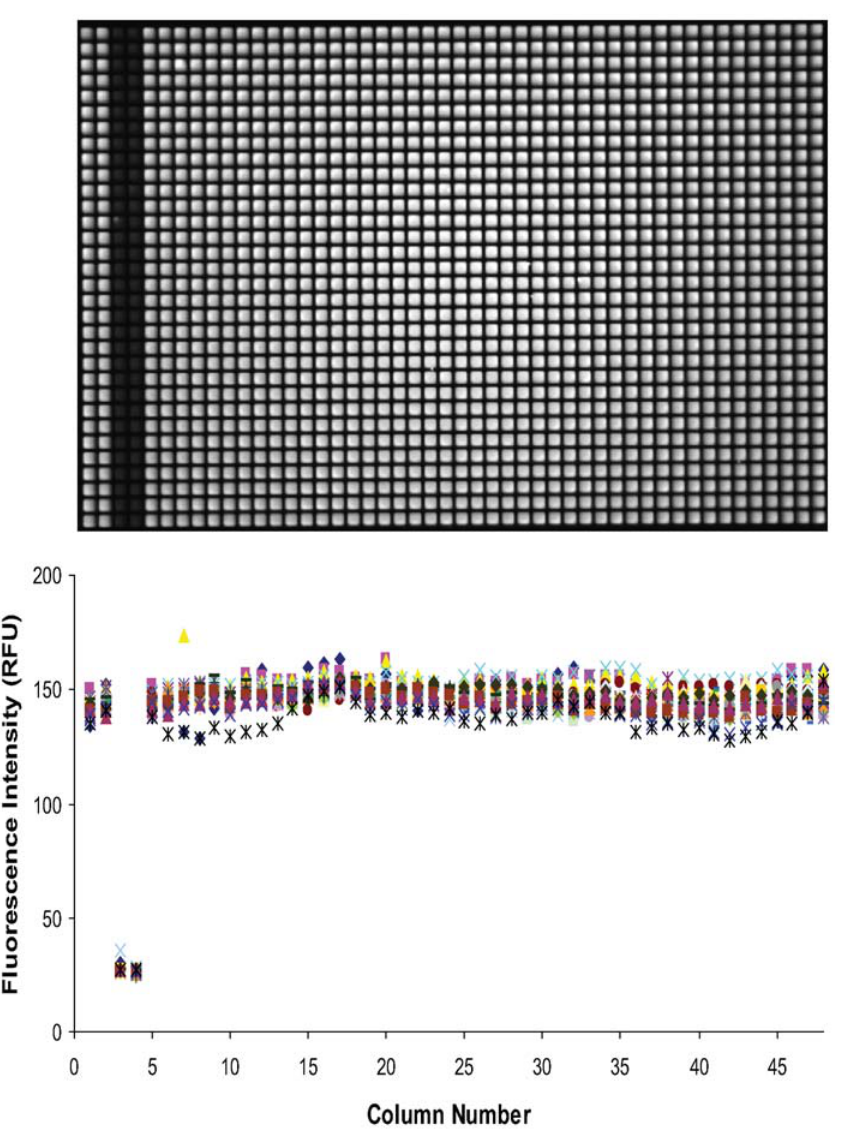
Figure 1. Assay Miniaturization to 1,536-well format. Plate image (above) is shown with quantitation (below). Columns 1,2,5–48 are 15 m M ApoF + 1-AMA, column 3,4 are free 1-AMA. 3 m L total volume, 15 min. incubation prior to fluorescence read. Top = raw ViewLux CCD image; bottom = RFU data from CCD image demonstrating consistency. The Z’ factor and signal-to-background calculated from the first 128 wells of data (left four columns) were 0.87 and 5.3, respectively.